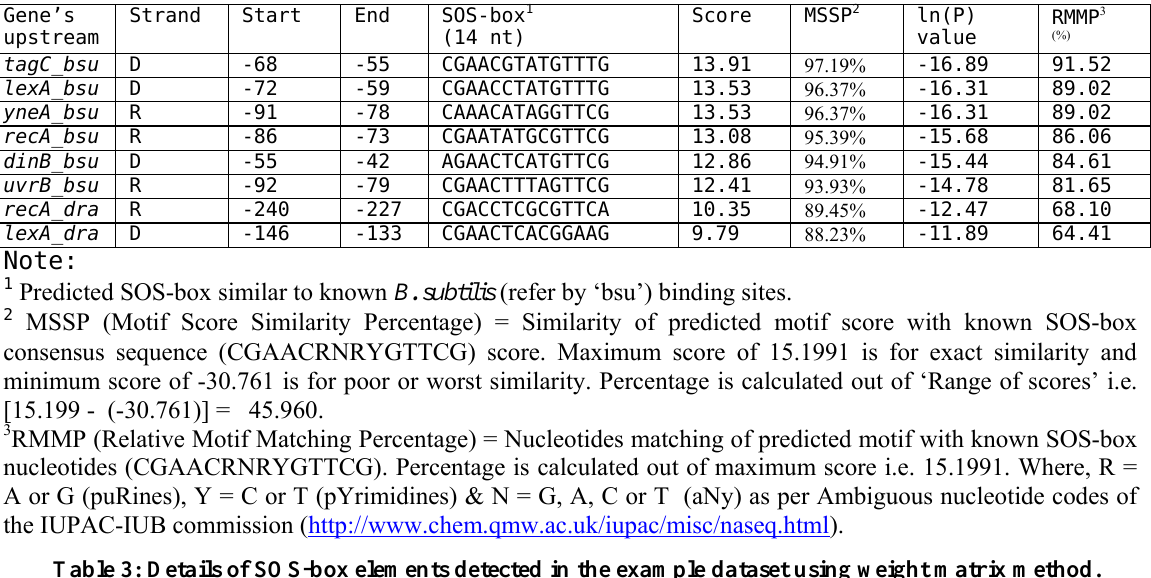
Table 3: Details of SOS-box elements detected in the example dataset using weight matrix